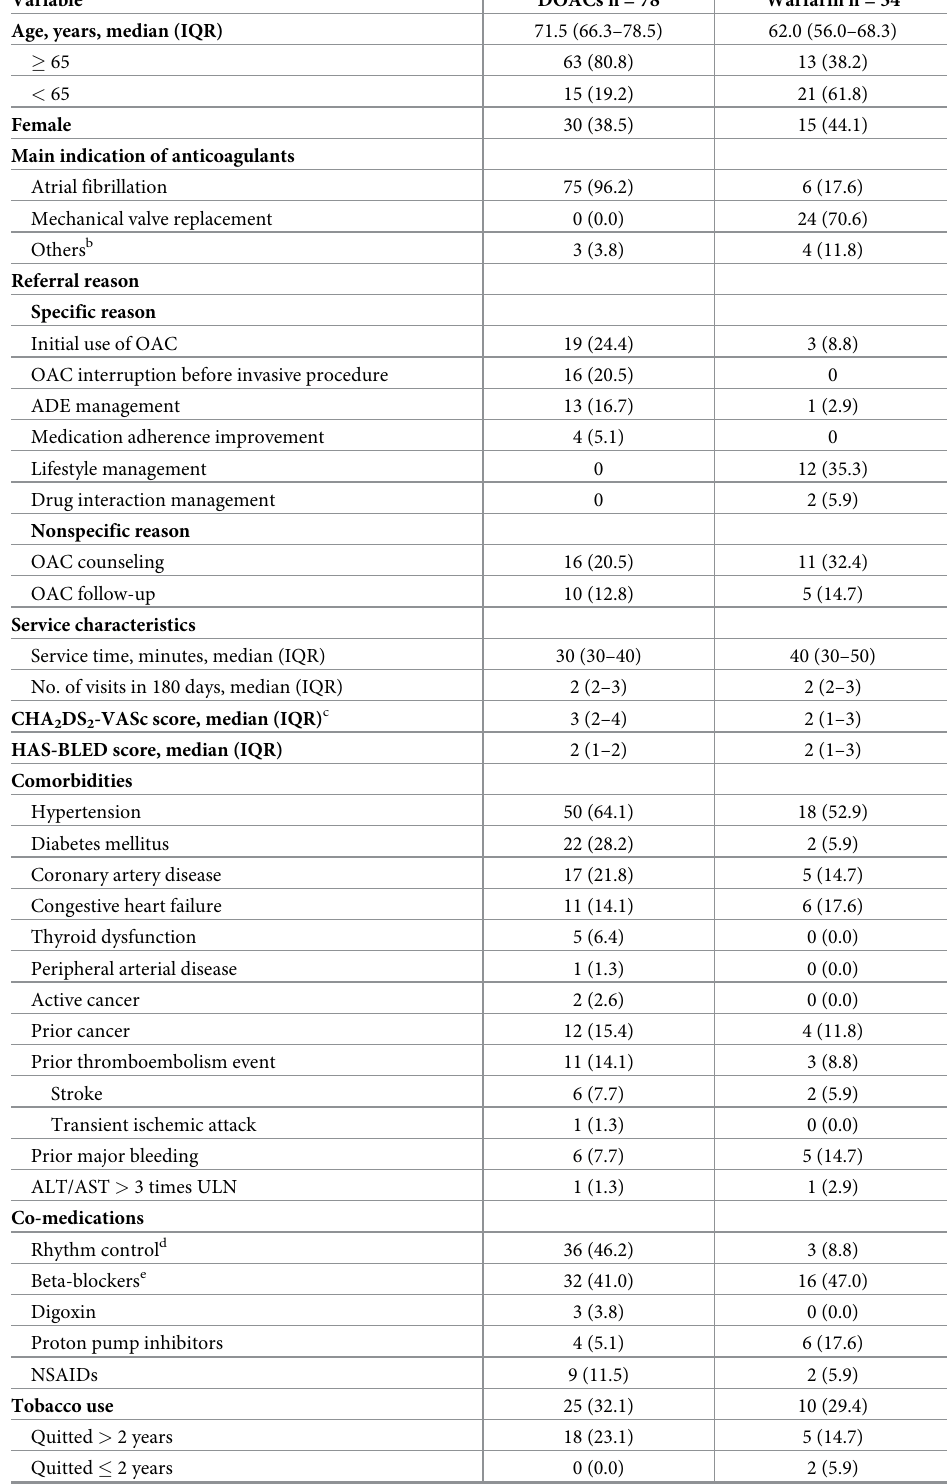
Table 1. Clinical characteristics of the participants a